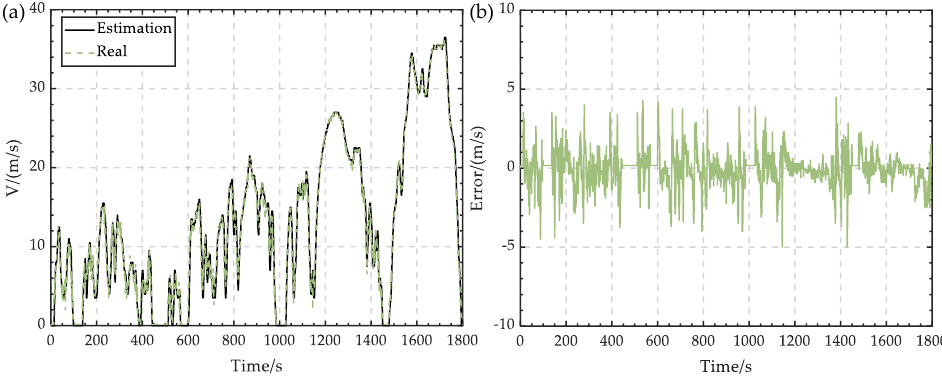
Figure 5. Speed prediction. ( a ) Speed prediction results. ( b ) Prediction error.